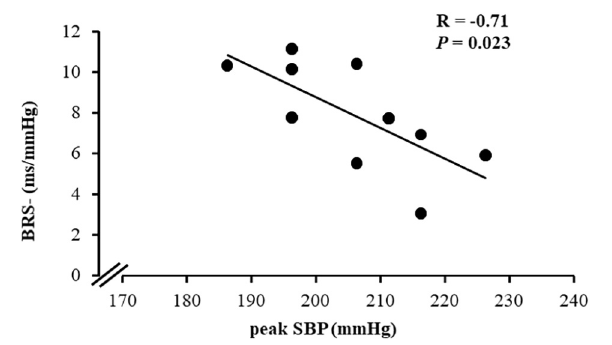
FIGURE 5 | Correlation between peak systolic BP (peak SBP) during CPET and spontaneous baroreflex sensitivity for decreases in blood pressure (BRS − ) in the subgroup of normotensive patients with MetS who presented exaggerated SBP during CPET (MetS_NT+, n =